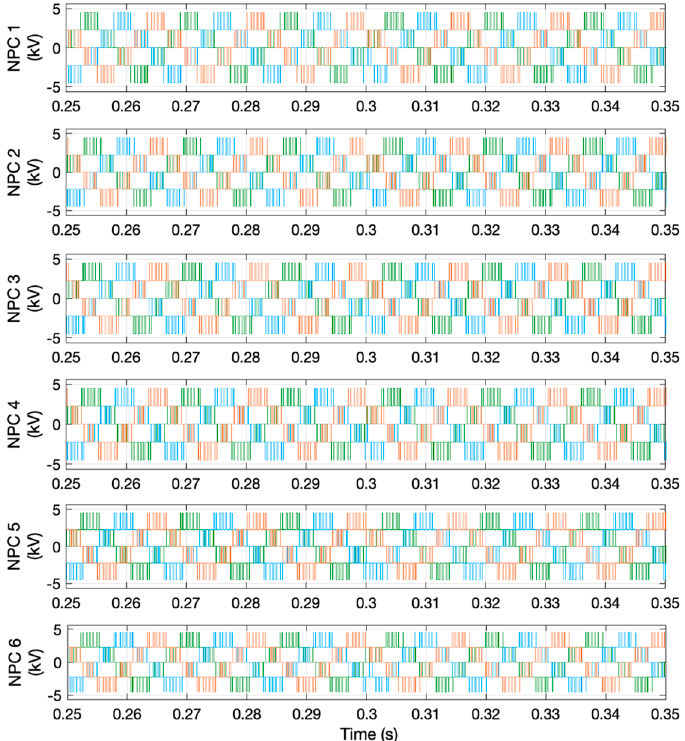
Figure 26. The output voltage of the NPC converters (six NPC converters’ outputs are shown for illustration).